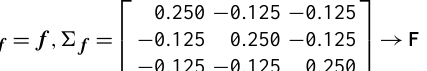
correlation coefficients